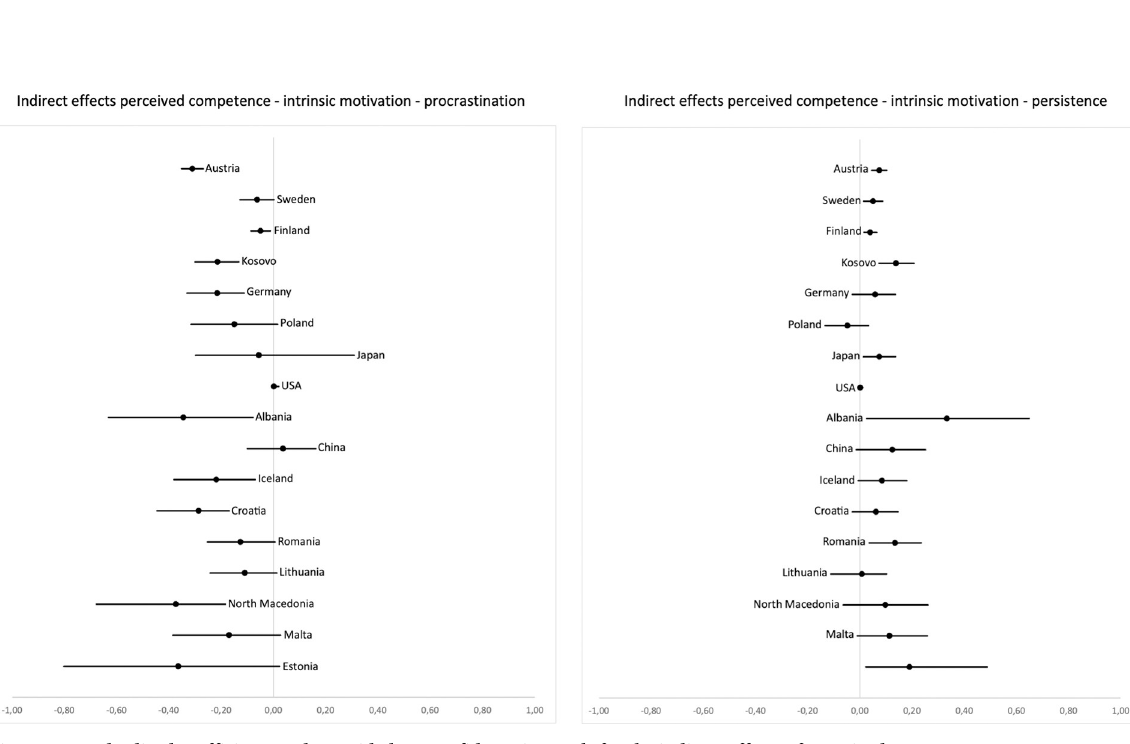
Fig 4. Unstandardized coefficients and two-sided 5% confidence intervals for the indirect effects of perceived competence on procrastination (left) and persistence (right), mediated by intrinsic motivation. Countries are ordered by sample size from top (highest) to bottom